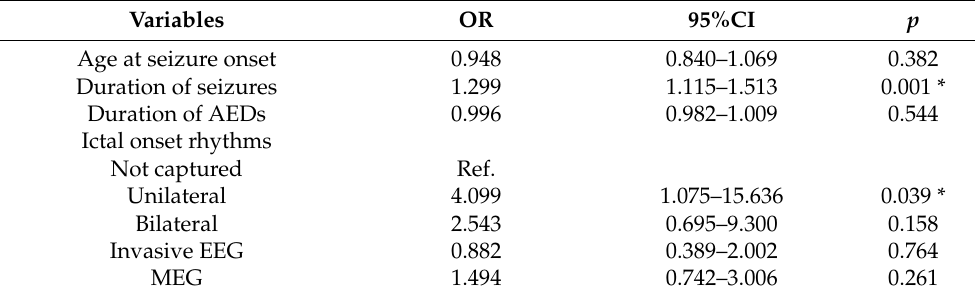
Table 3. Predictors of seizure outcomes in the resection surgery group for DRE on multivariate analysis ( n = 185). Variables OR 95%CI p Age at seizure onset